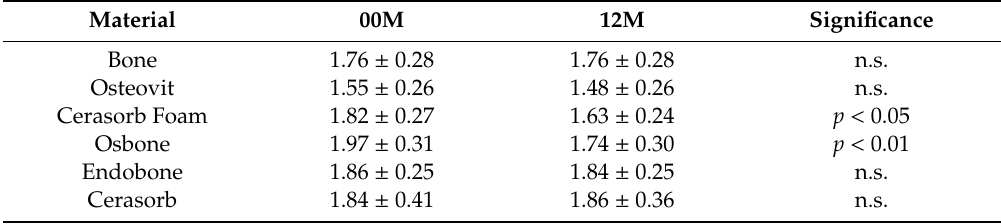
Table 1. Time dependent alteration of the texture index (Entr / LngREmph) in the implantation site. Material 00M